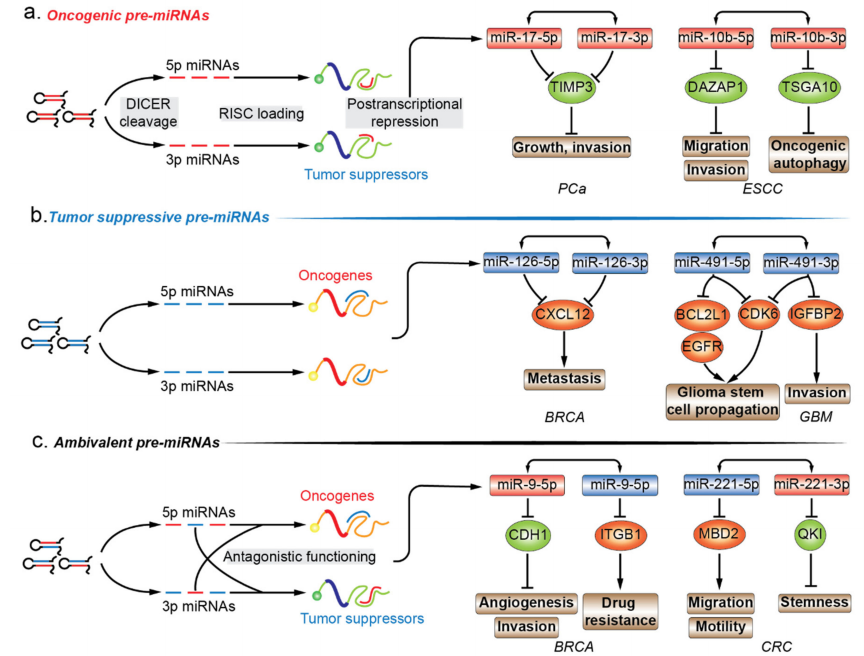
Figure 2. Functional annotation of miRNA precursors by dual regulatory strands. ( a ) The oncogenic pre-miRNAs produce two oncomiRs synergistically contributing to the oncogenic process under a certain cellular context by post-transcriptional regulation of tumor suppressors. ( b ) Conversely, the two mature products of tumor suppressive pre-miRNAs target two sets of oncogenes, respectively. ( c ) An ambivalent pre-miRNA is processed into two mature miRNAs that have simultaneous conflicting reactions toward cancer progressions. PCa, prostate cancer; ESCC, esophageal squamous cell carcinoma; BRCA, breast cancer; GBM, glioblastoma; CRC, colorectal